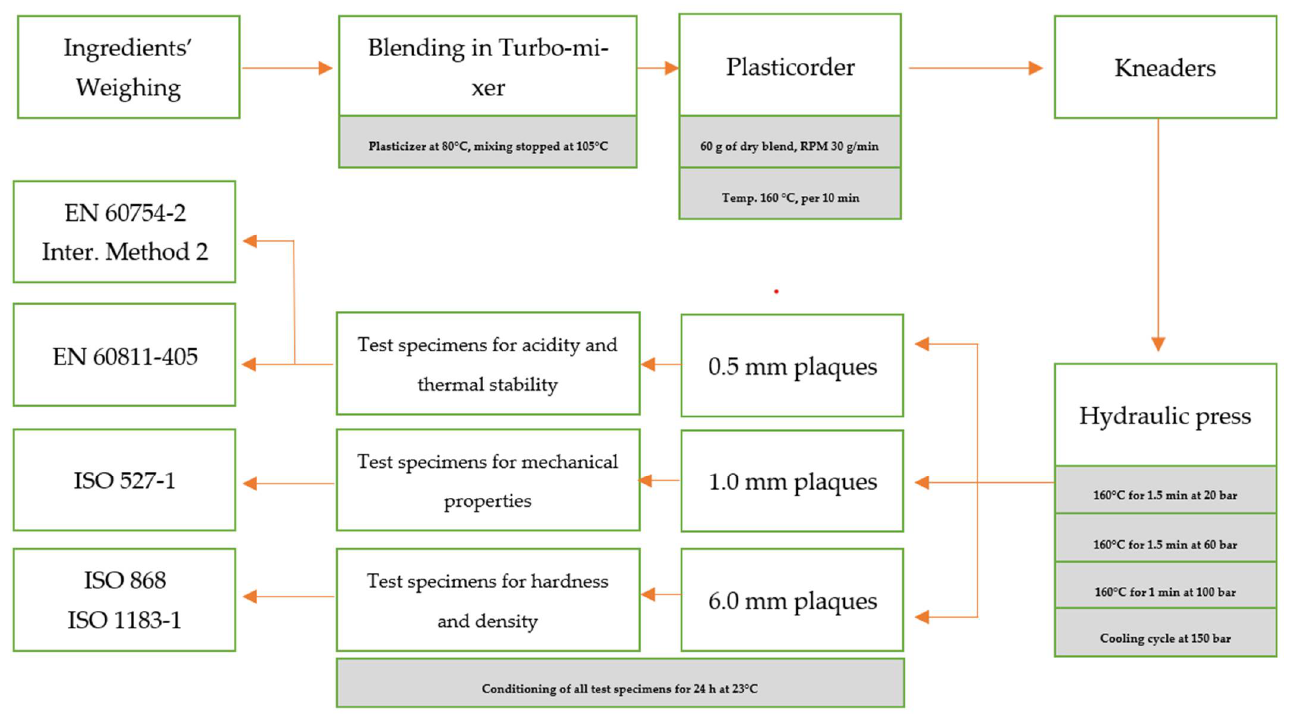
Figure A12. A schematic diagram of the sample preparation .